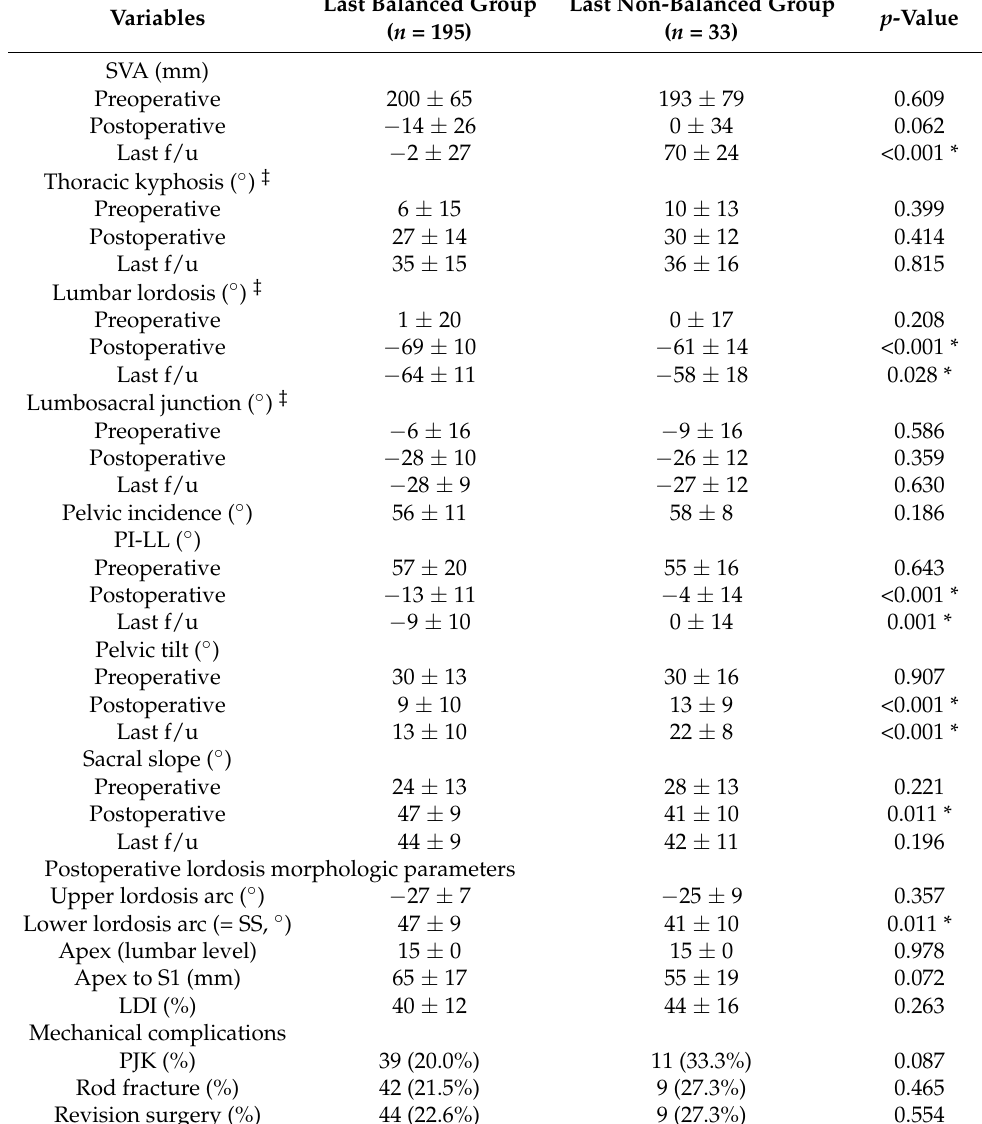
Table 2. Comparison of radiographic parameters and mechanical complications between balanced and non-balanced groups †